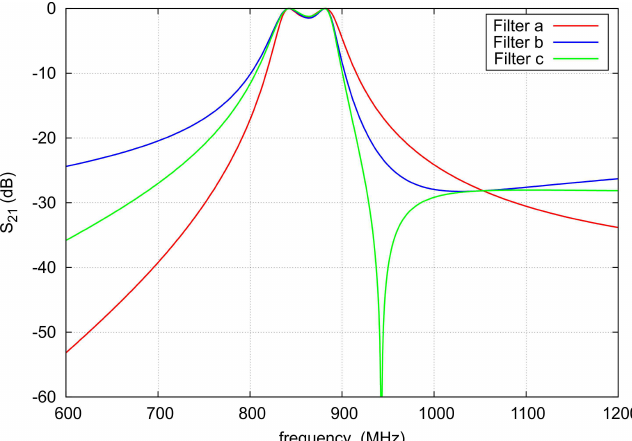
Figure 2. Frequency behaviour of s 21 of the double-tuned coupled resonator filter versions presented in Figure 1.